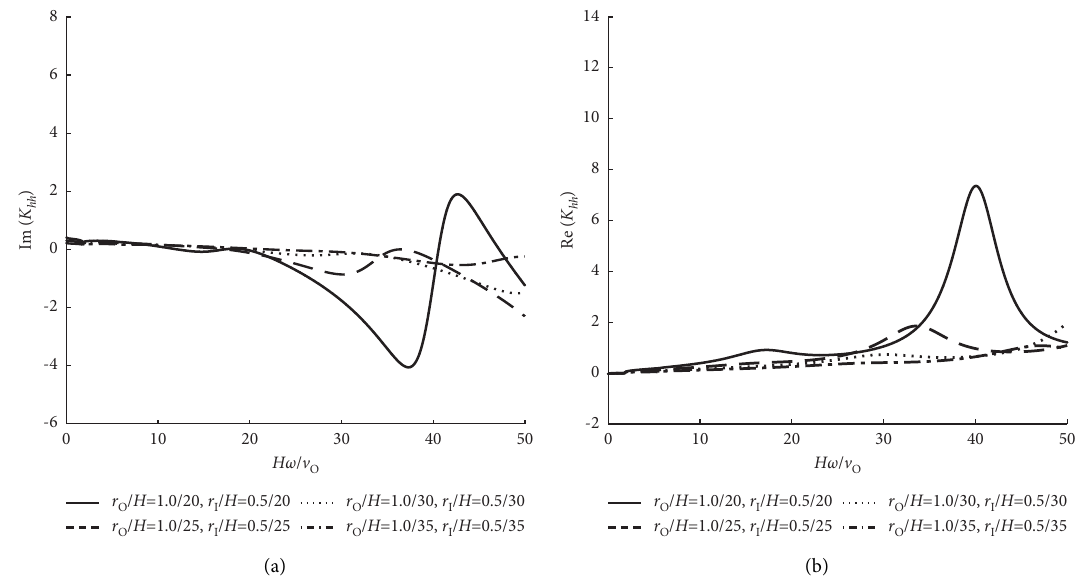
Figure 18: The horizontal dynamic impedance curves of pipe pile under different lengths of pipe pile. (a) Real part of horizontal dynamic impedance. (b) Imaginary part of horizontal dynamic